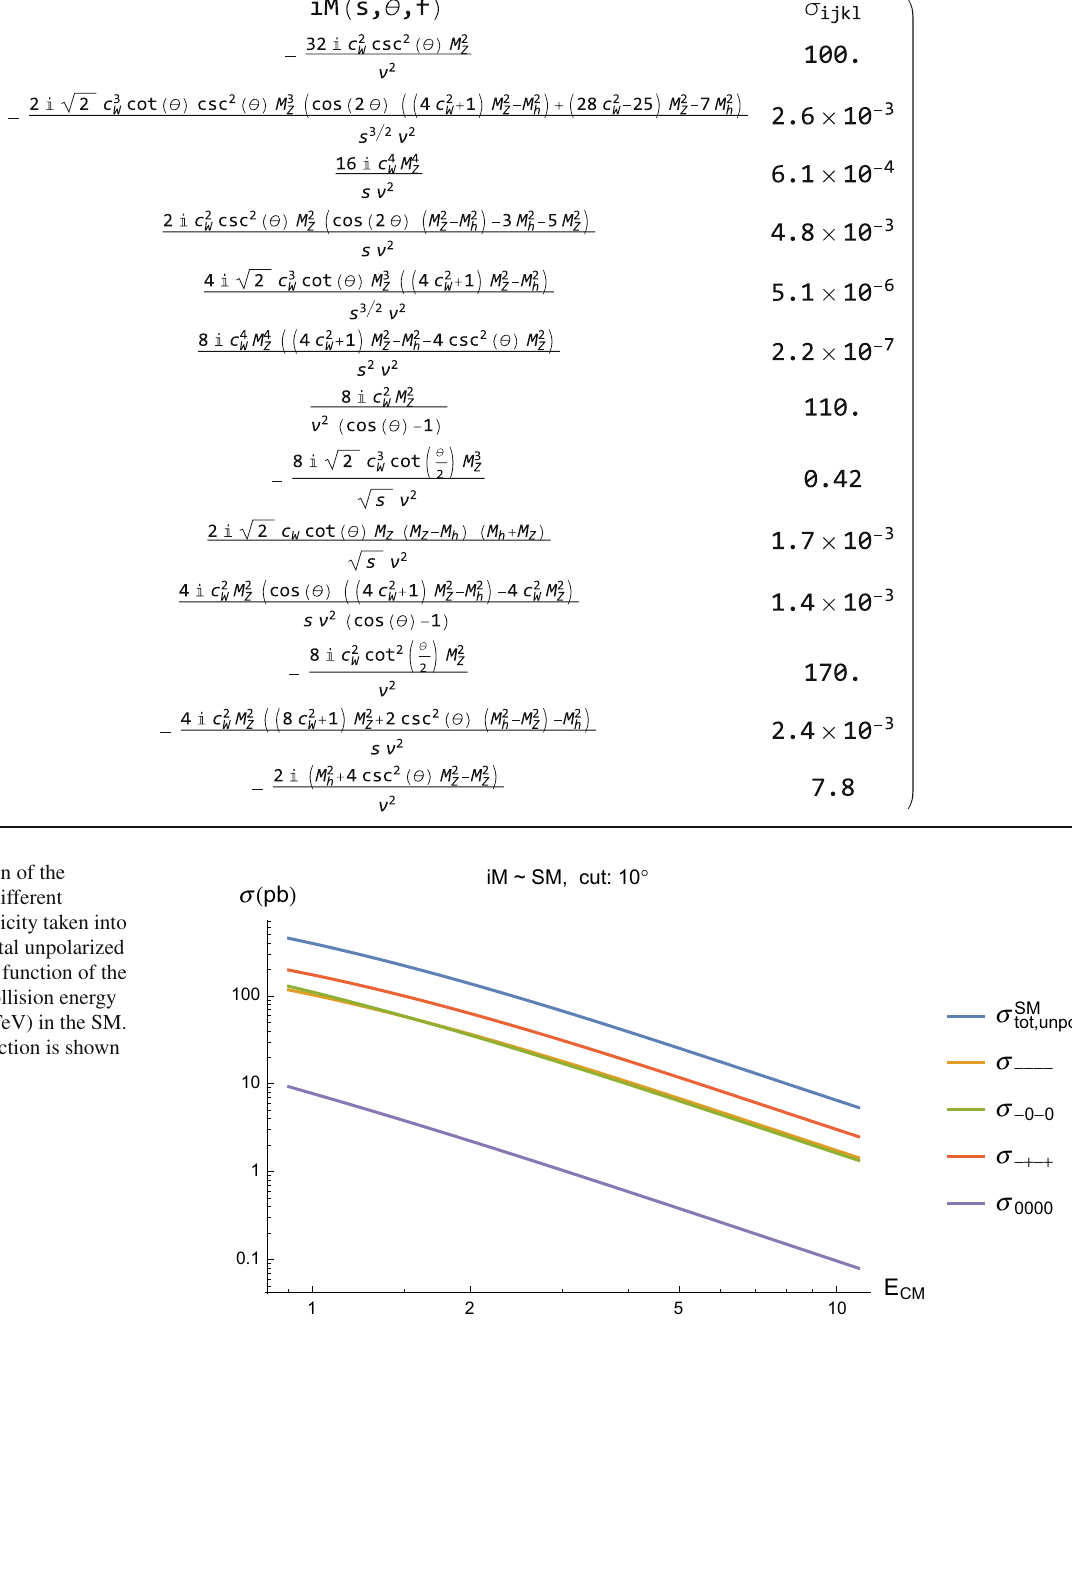
Table 2 The leading energy behavior in the limit s >> ( EW scale ) 2 of the scattering amplitude iM for all the 13 independent helicities in the SM case. In the third column shown are numerical values (in pb) of the